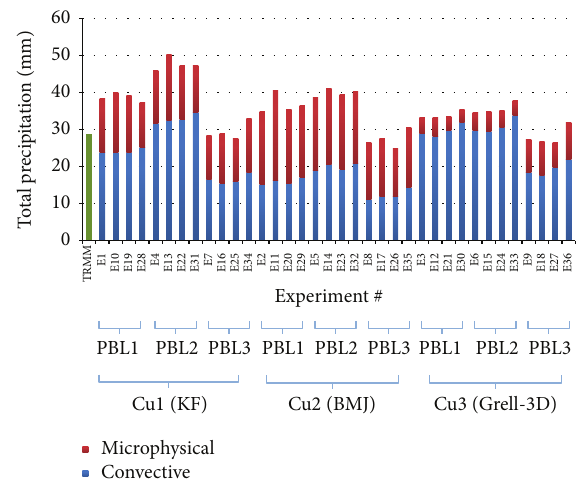
Figure 4: The area-averaged microphysical (red) and cumulus (blue) rainfall over the entire nested domain from 36 combinations of physical parameterization schemes together with the TRMM data